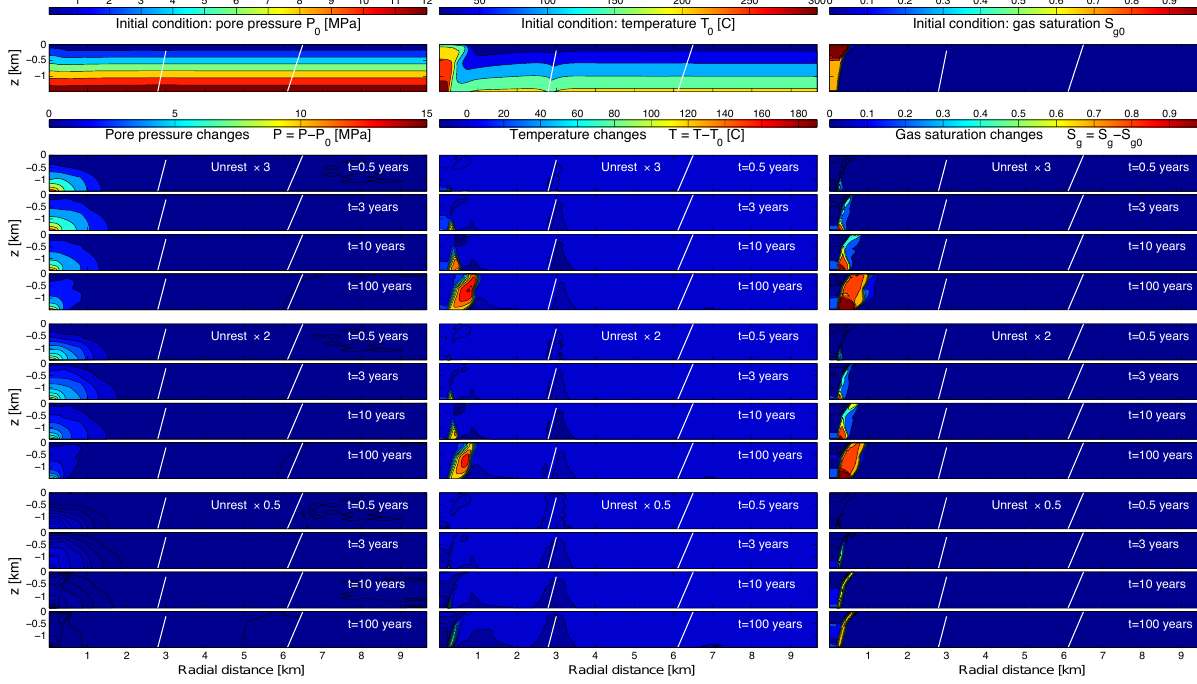
Figure 6. Changes in pore pressure, temperature and gas saturation relative to the steady-state initial condition at different times after the initiation of unrest for Scenario I. Initial conditions are obtained as the steady-state solutions of central injection of 2400 of H 2 O and 1000tonsday − 1 of CO 2 , through a cylindrical conduit with radius 200m. Unrest is simulated by injecting a mixture of H 2 O and CO 2 through the central conduit. Injection rates for the unrest simulation are listed in Table 4. Note that the colour scale of initial conditions is different from either the respective colour scale of unrest plots or the colour scale of Fig.